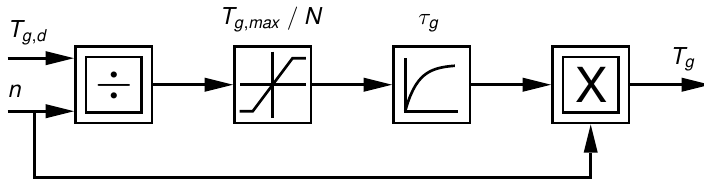
Figure 4. Reference signal adaptation for demanded generator